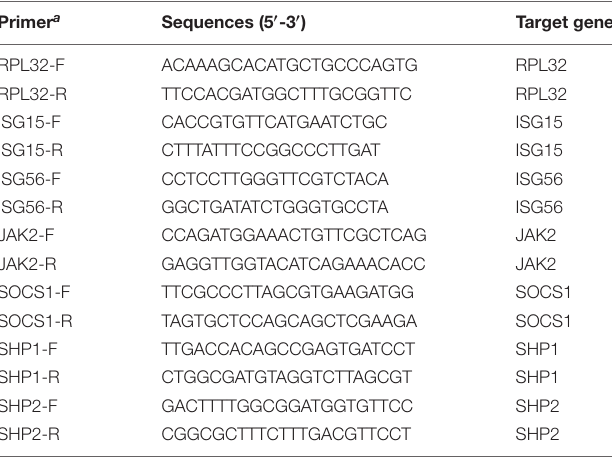
TABLE 1 | List of primers for real-time